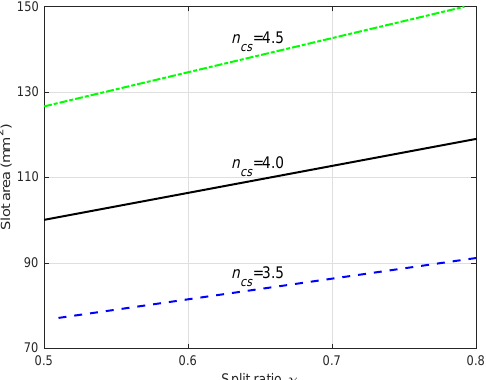
Figure 6. Variation in slot cross-section area with split ratio for a 48-slot 8-pole SynRM ( n cs is assumed to be 3.5, 4.0 and 4.5,